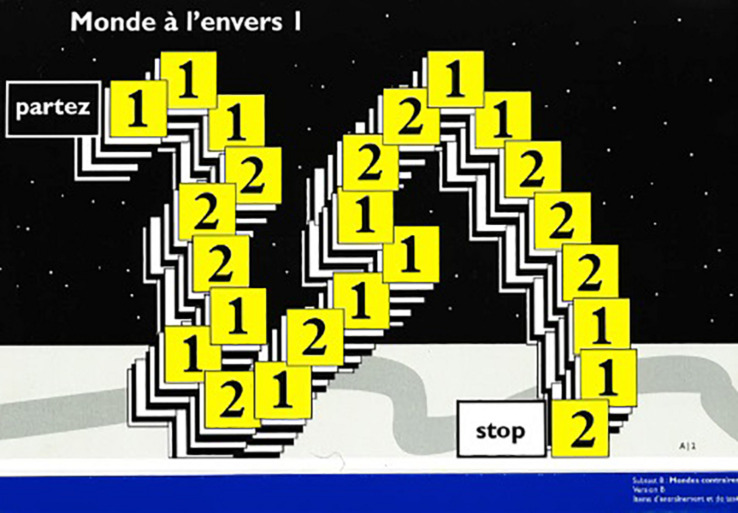
An example of an Opposite World condition (Monde à l’envers in French) in which participants had to say the opposite of what they saw (“two” when they saw the digit 1 and “one” when they saw the digit 2).